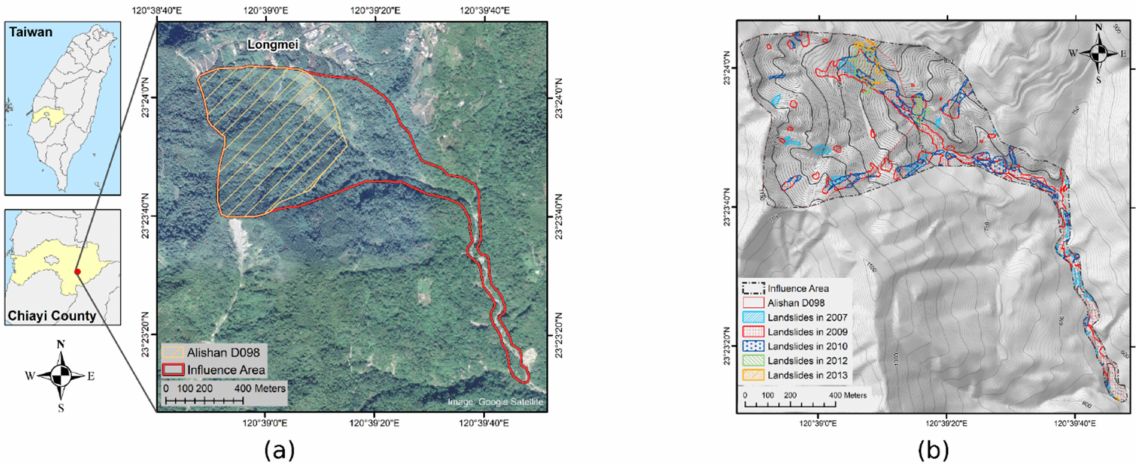
Figure 2. ( a ) Location of the influence area of Alishan D098; ( b ) the historical landslide areas by